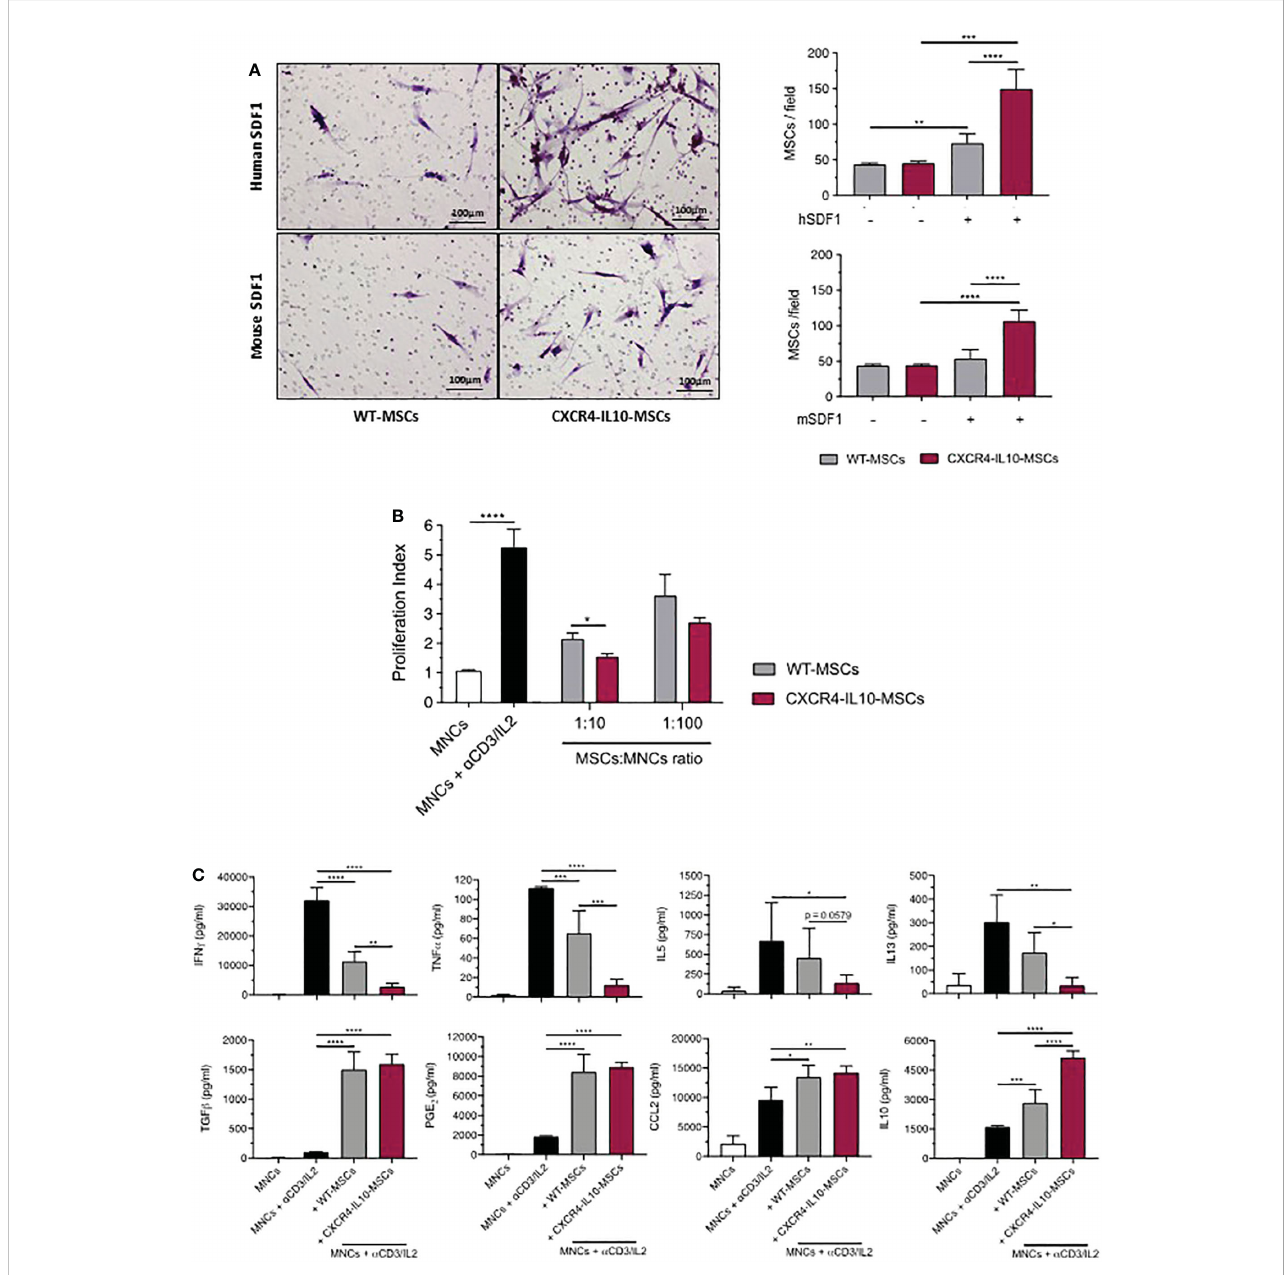
FIGURE 2 Enhanced migration towards SDF-1 a and immunosuppression potential of CXCR4-IL10-MSCs. (A) Representative images of transwell-migration of WT- MSCs and CXCR4-IL10-MSCs in response to human and mouse SDF-1 a . Cells in the transwell membranes were stained with hematoxylin. Right panels represent the mean number of MSCs per fi eld that migrated in response to human and mouse SDF-1 a . (B) In vitro immunosuppressive capacity of CXCR4-IL10-MSCs compared to WT-MSCs. The results correspond to the proliferative index of human T cells activated with anti-CD3/IL2 and treated with the corresponding Ad-MSCs. (C) Analysis of cytokine levels in supernatants collected 3 days after initiation of co-cultures (1:10 cell ratio). Bars represent the mean ± SD of n = 3-5 different experiments. *p < 0.05; **p < 0.01; ***p < 0.001. **** p